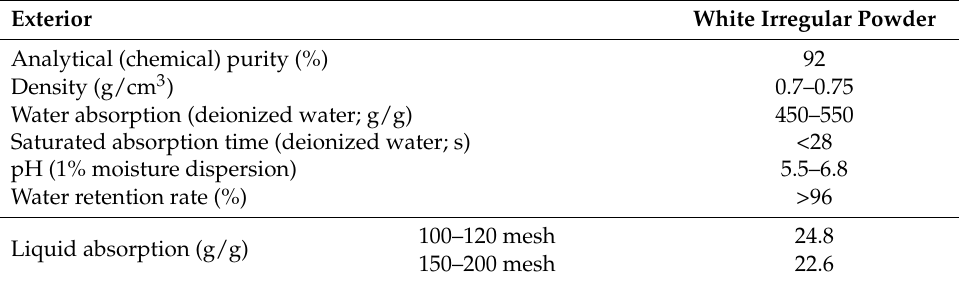
Figure 2. Morphology of SAPs: ( a ) Dry SAPs; ( b ) SAP gels after water absorption. Table 1. Main technical indicators of SAP.